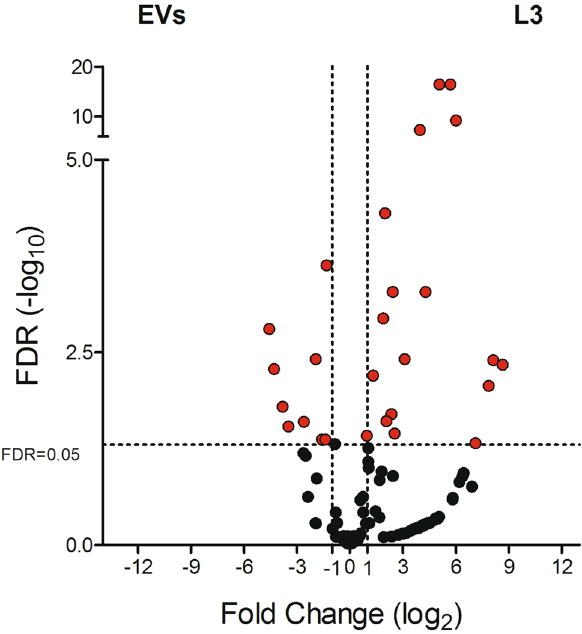
Figure 5. Volcano plot with the differential abundance of miRNAs in the pairwise comparisons between third- stage larvae (L3) and in the extracellular vesicles-enriched fraction (EVs) of in Anisakis pegreffii . The log2 fold change (FC) versus the negative log10 of false discovery rate (FDR) as calculated by the Fisher’s exact test are reported. Vertical dotted lines mark logFC = 2, horizontal dashed lines mark FDR threshold equal to 0.05.